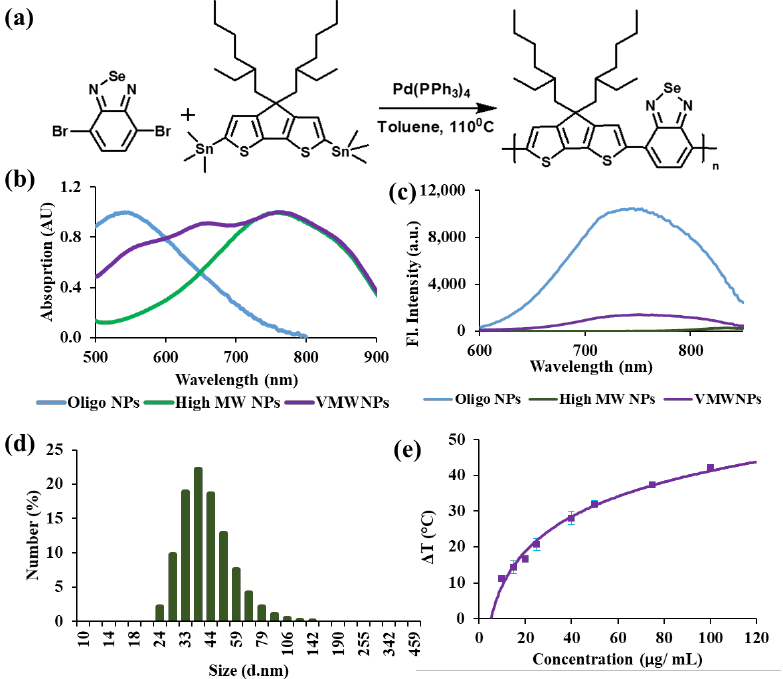
Figure 1. ( a ) Synthesis of PCPDTBSe by Stille coupling. ( b ) Absorbance and ( c ) fluorescence spec- trum of oligomer, high MW BSe NPs and VMWNPs. ( d ) VMWNPs size. ( e ) Concentration vs. tem- perature change in VMWNPs with 800 nm (3 W, 60 s)